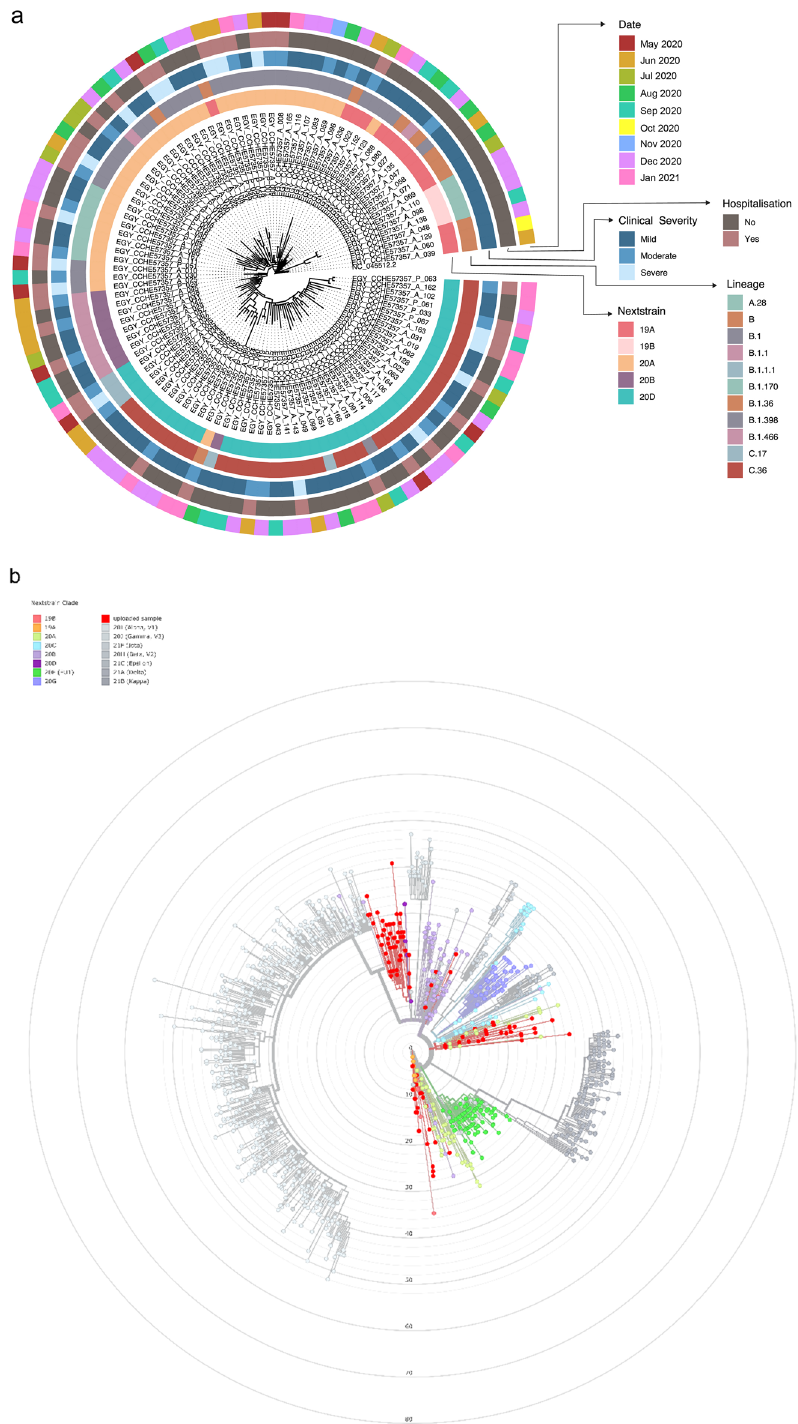
Figure 1. Phylogenetic analysis of 110 SARS-CoV-2 samples included in this study. ( a ) Maximum likelihood phylogenetic tree of 110 SARS-CoV-2 sequences and Wuhan-Hu-1 reference sequence. Visualization of the tree was done using ggtree R package 28 . For each sample, date of sample collection, clinical severity, hospitalization, nextstrain clade and PANGO lineage are indicated by the circular color strip around the tree according to the legend. ( b ) 110 sequenced samples included in this study were placed on Nextclade https:// clades. nexts train. org/ 26 . The circles represent the sequences from our study in comparison with published sequences from all over the world. Nextstrain clades are broken down according to the indicated color